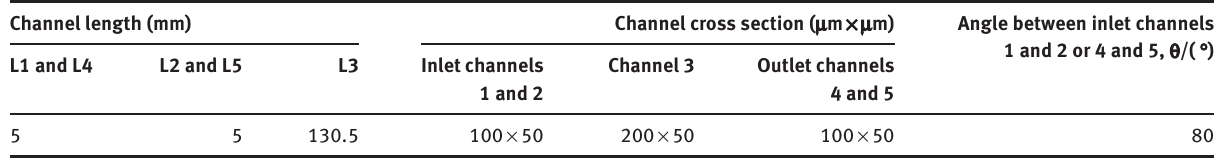
Table 1: Specifications of the microreactor used in the study. Channel length